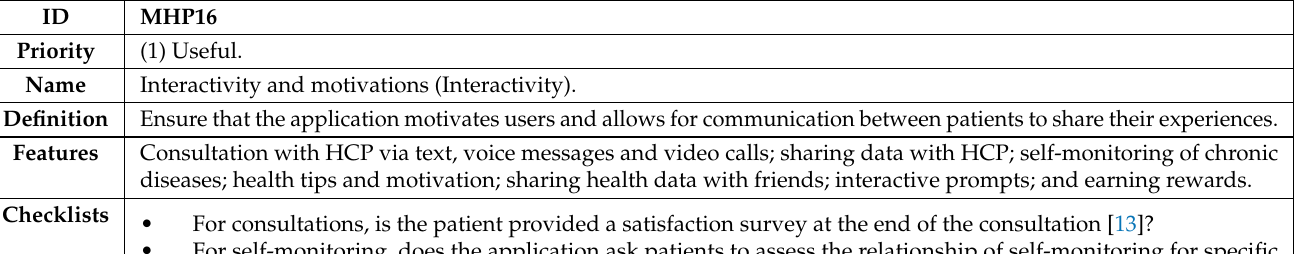
Table A16. Descriptive details of the sixteenth